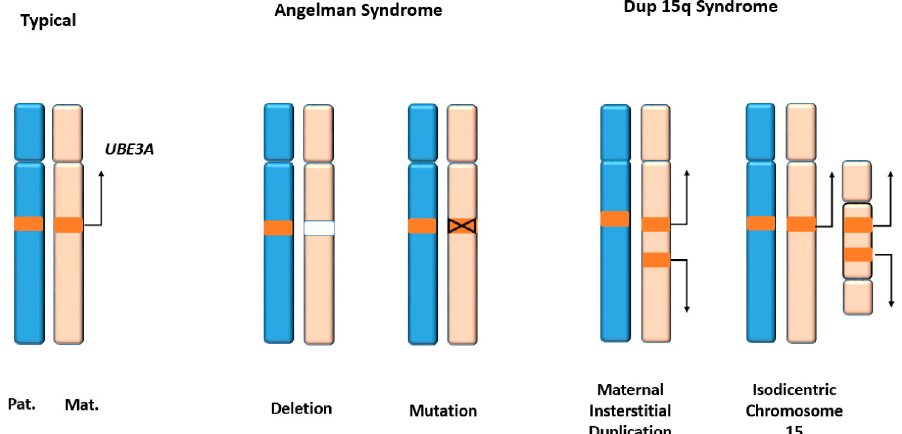
Figure 3. Genetic alterations in UBE3A locus. The UBE3A gene is located in chromosome 15 region q11.2-q13. Typically, only the maternal copy is expressed while the paternal copy is silenced in neurons. In Angelman syndrome (AS), the maternal allele is deleted or mutated. Multiple copies of UBE3A are expressed in Dup15q syndrome, which is characterized by autism spectrum disorder (ASD) phenotypes.